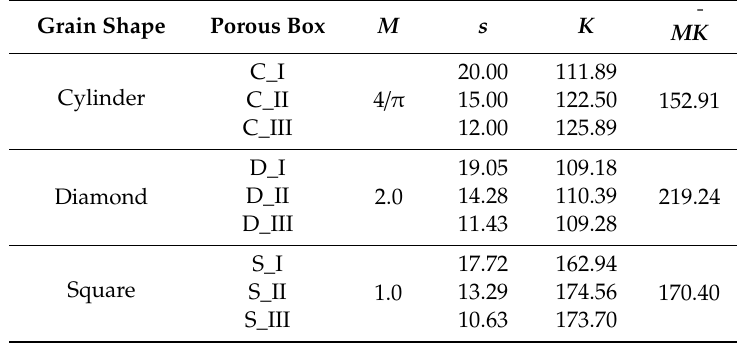
Table 4. The values of parameter K for di ff erent porous boxes.